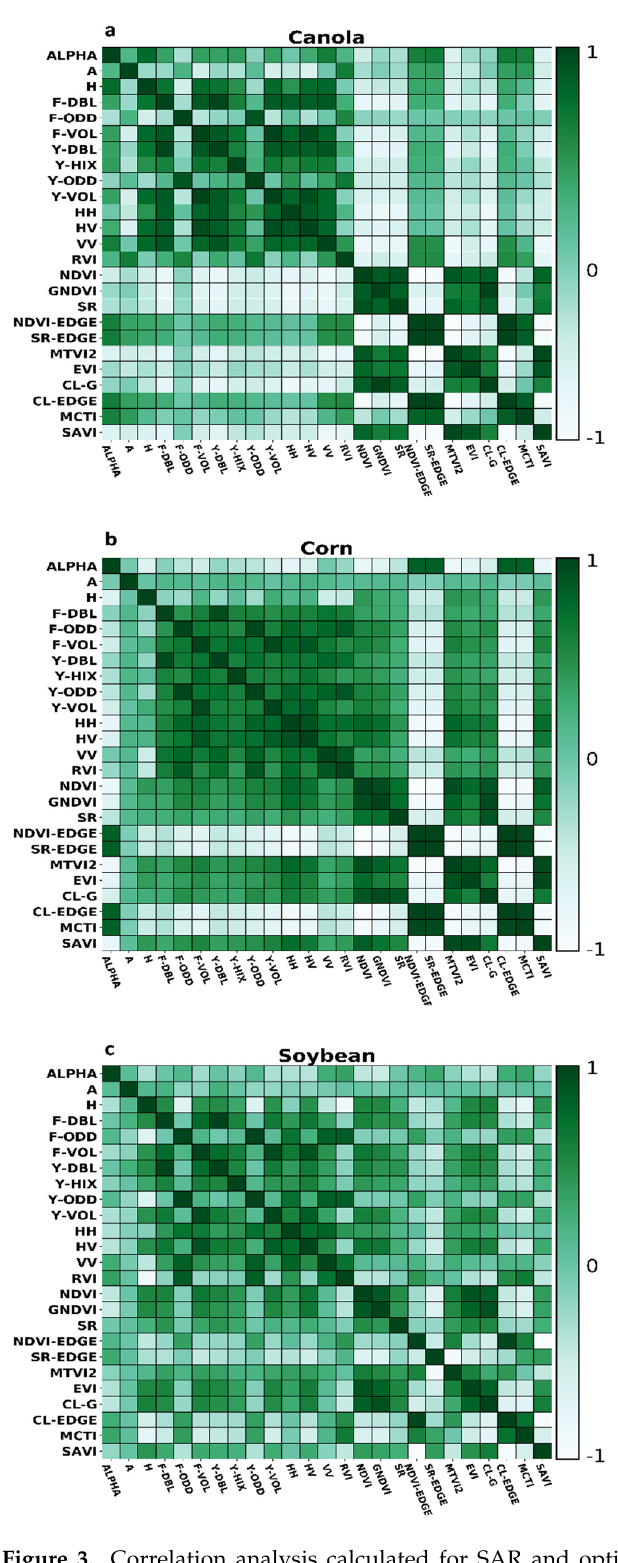
Figure 3. Correlation analysis calculated for SAR and optic features for ( a ) Canola, ( b ) Corn, ( c )